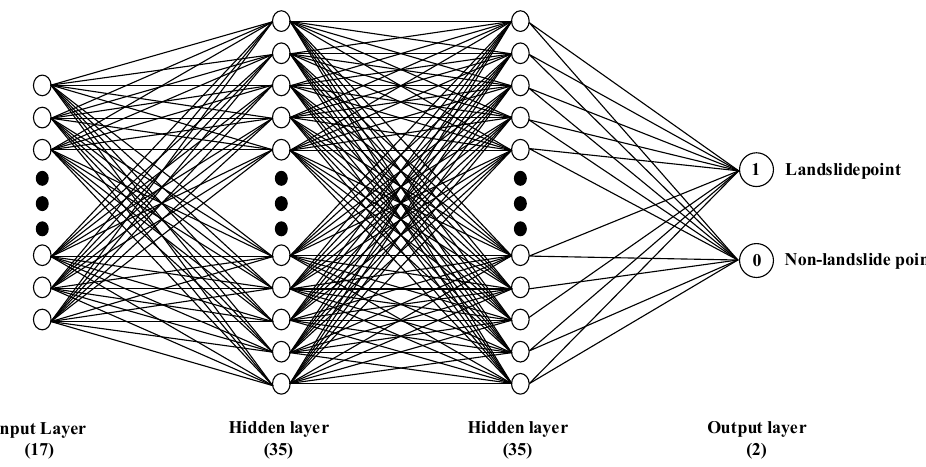
Figure 5. Structure of the constructed deep neural network (DNN) model.